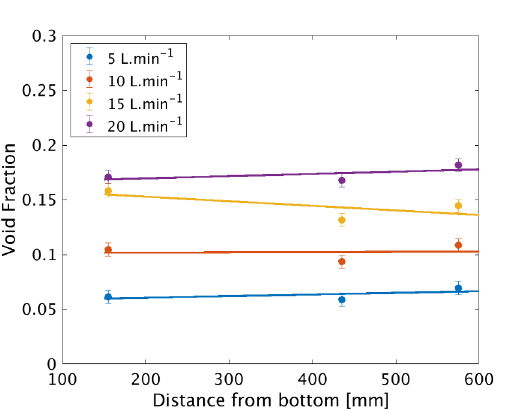
Figure 3: Axial evolution of the void fraction in the channel using attenuation